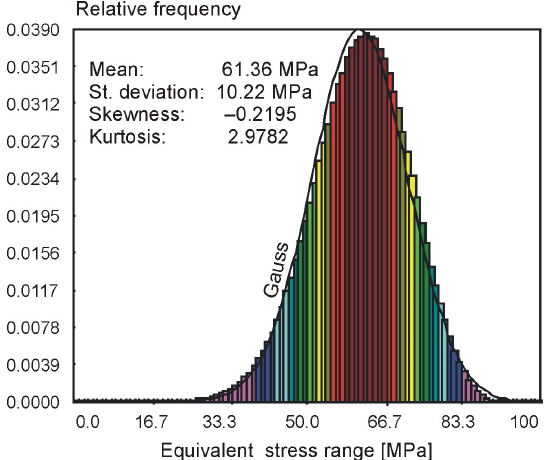
Fig. 4. Density function of equivalent stress range